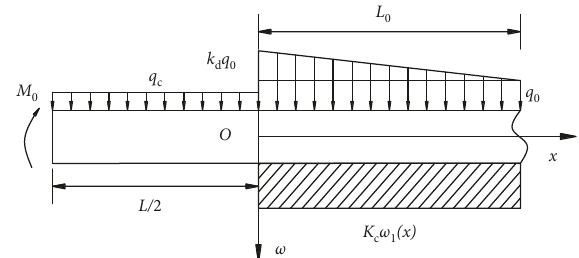
Figure 4: Mechanical model of the hard roof before the initial breakage event.